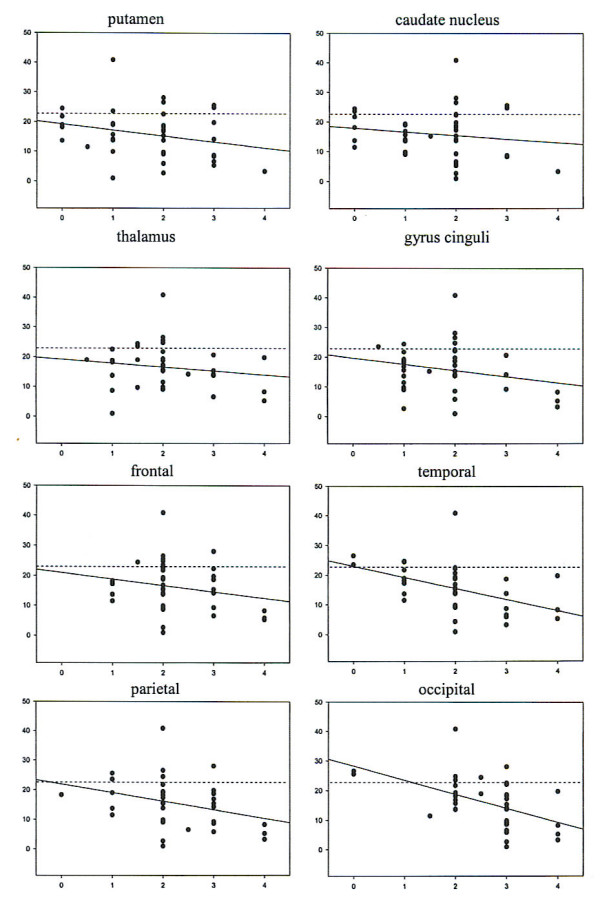
Correlation between PrP CSF levels and degree of neuronal loss in various brain areas. (- - - - - - cut-off 22 ng/100 ml).